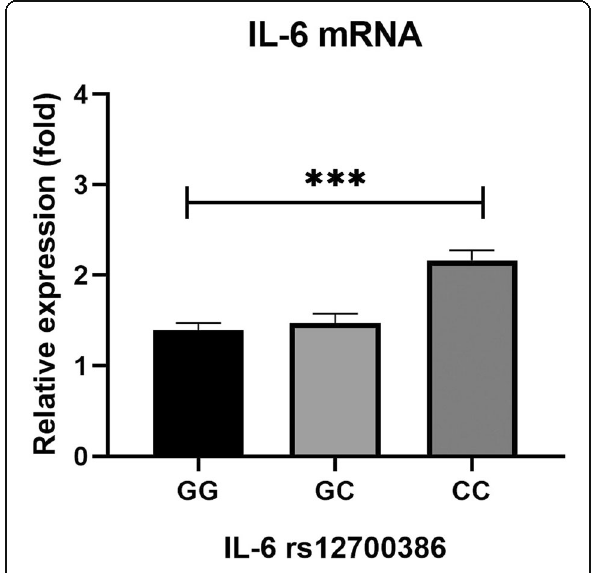
Fig. 1 Comparison of relative expression levels of IL-6 mRNA between patients with different IL-6 rs12700386 genotypes. Analyses were performed on OA patients ’ peripheral venous blood; GG ( n = 193) vs GC ( n = 134) vs CC ( n = 24); Relative expressions were analyzed using the 2 △△ CT method. The Mann-Whitney U test was used to compare the 2 △△ CT between groups. (*** p <